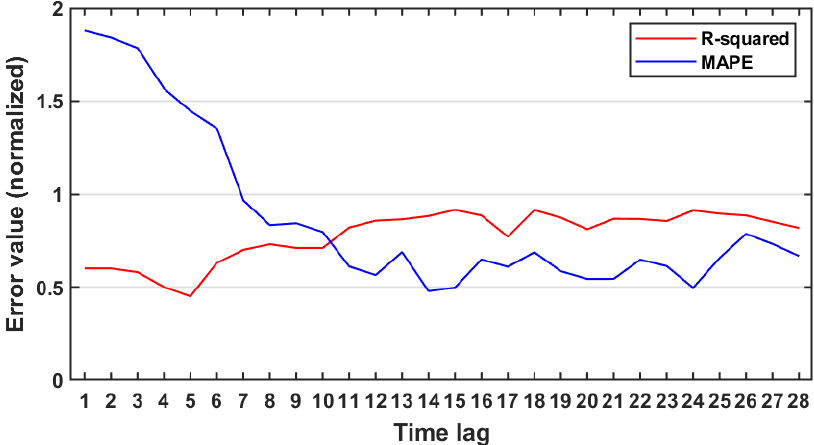
Figure 9. R-squared and MAPE of LSTM output with time-lag values in range